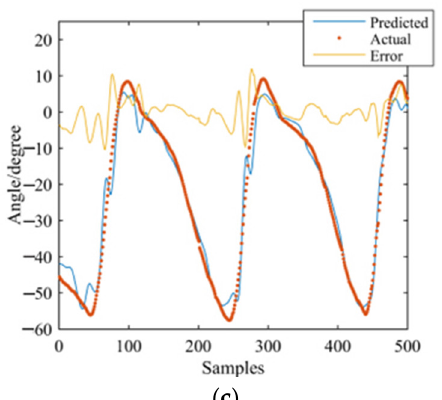
Figure 17. Prediction results of knee-joint angle in the going downstairs process. ( a ) Results of IN1; ( b ) Results of IN2; ( c ) Results of IN3.